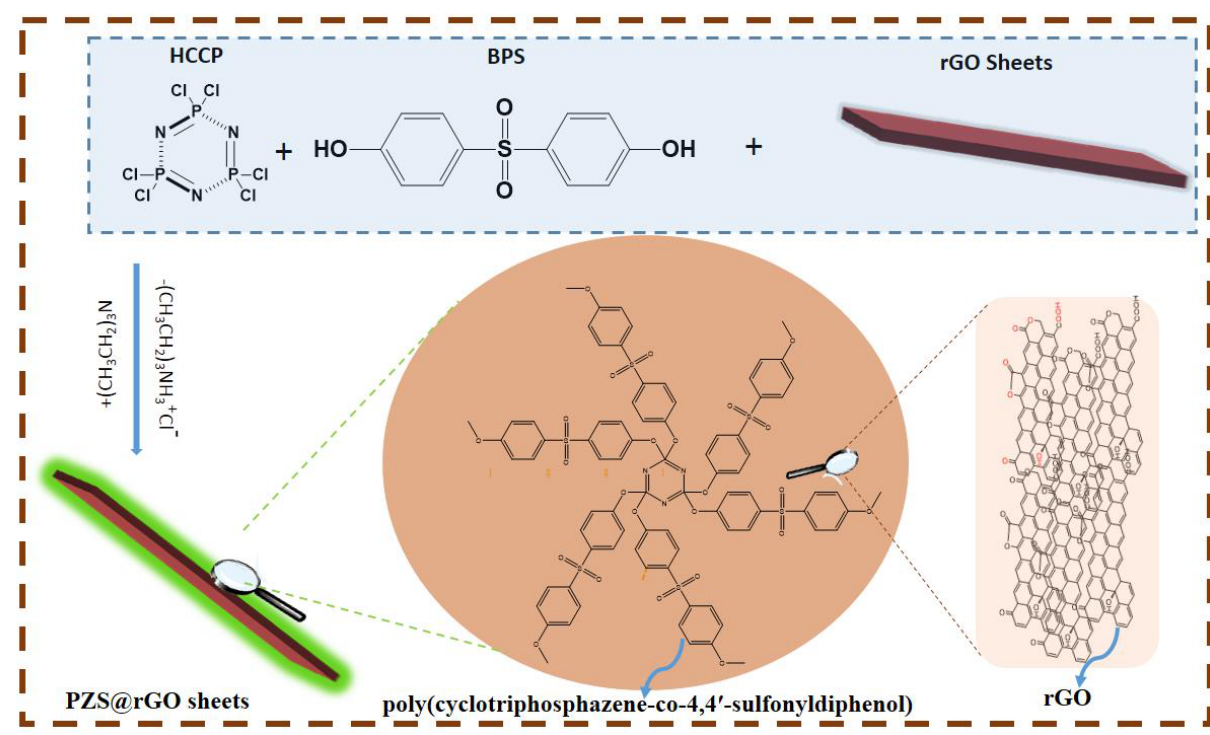
Figure 1. Scheme for the formation of PZS@rGO.